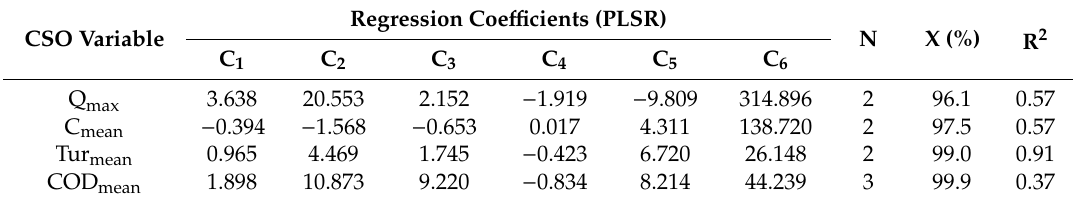
Table A5. Regression coe ffi cients for the prediction equations of the CSO variables as a function of the rainfall parameters for the Multifamiliares CSO. R 2 is the coe ffi cient of determination of the PLSR.-N is the number of components used to build the PLSR model and X is the percentage of variability explained by the model.